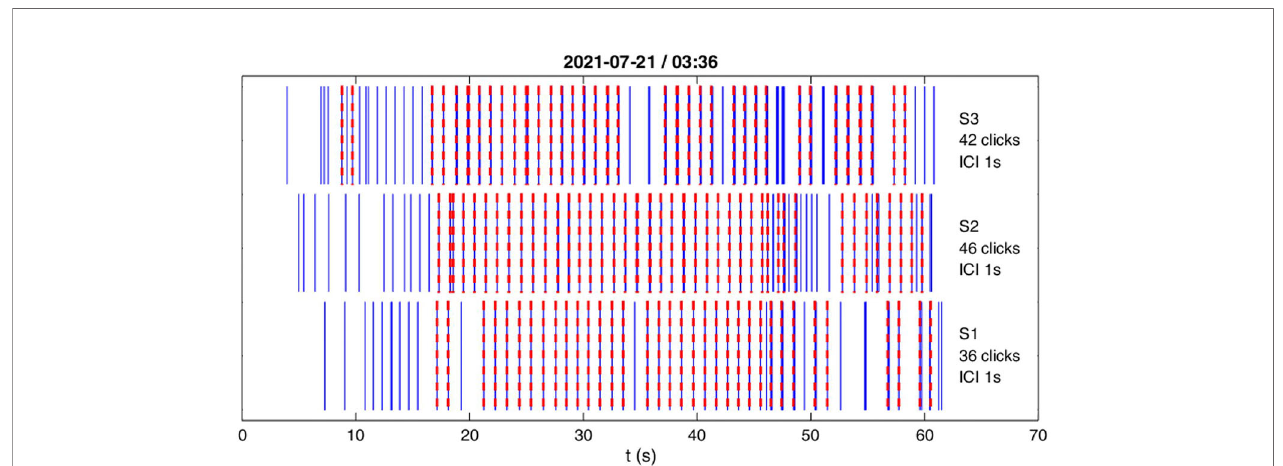
FIGURE 2 | Example for the detection of regular sperm-whale click patterns at the three hydrophones in a 1-minute record. The received arrival times are marked in blue and the selected/detected ones in red. The latter correspond to the peaks of the histograms of time differences (from 0.5 to 2 s) of arrivals at the three